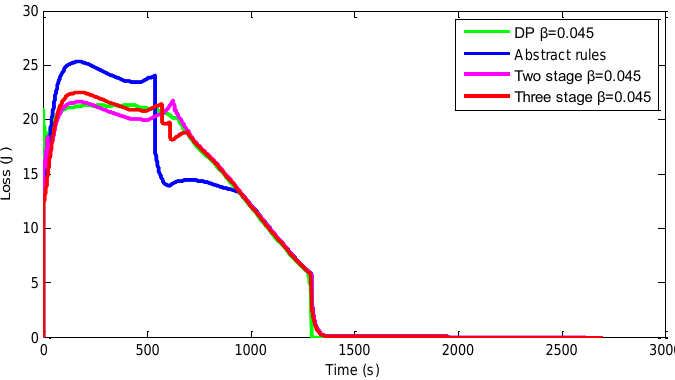
Figure 12. The charging loss comparison of three different methods.